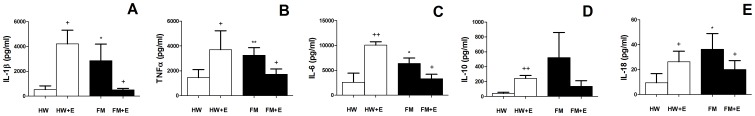
Effect of an acute session of moderate exercise (+E) on the release of cytokines by monocytes.IL-1β (A), TNF-α (B), IL-6 (C), IL-10 (D) and IL-18 (D) released by monocytes activated by LPS from healthy women (HW; n = 8) and FM patients (FM; n = 8). The results are presented as the mean value ± SEM of a set of independent experiments performed in duplicate (one experiment per volunteer). *p<0.05, **p<0.01 with respect to HW;+p<0.05,++p<0.01 with respect to each respective pre-exercise values.